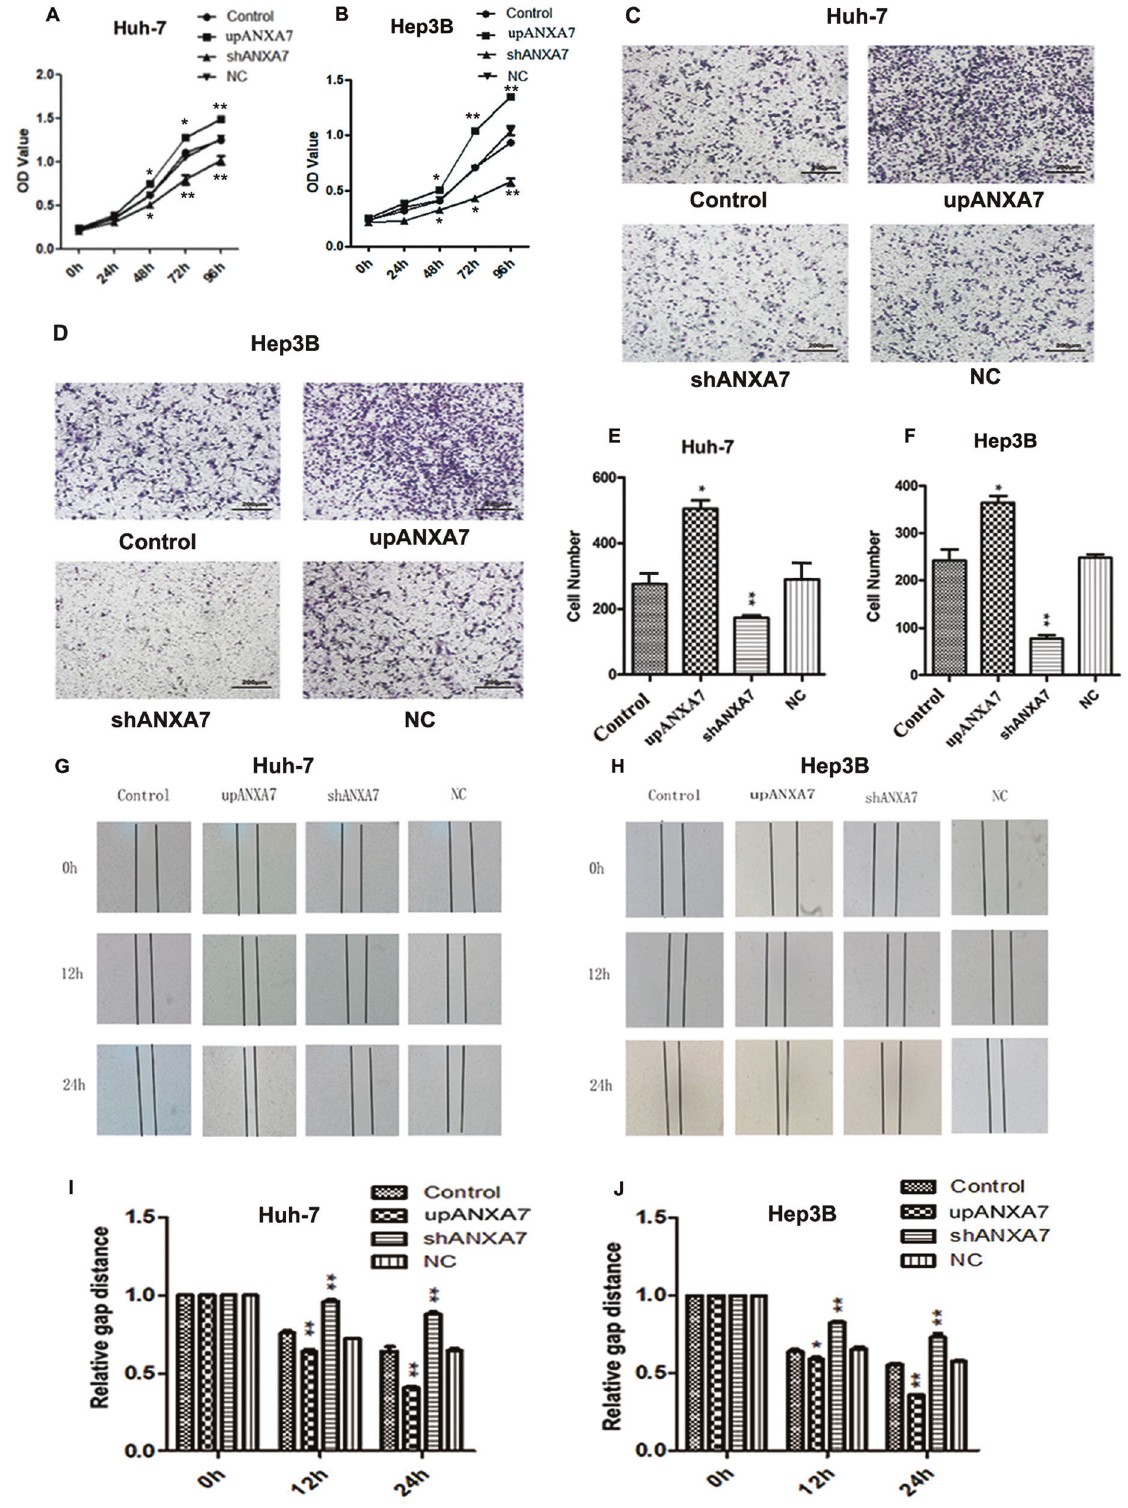
Fig. 4 The expression of ANXA7 affects the proliferation, invasion, and migration of HCC cells. A , B CCK8 assays showed that ANXA7 upregulation promoted the proliferation, whereas ANXA7 downregulation suppressed the proliferation of Huh-7/Hep3B cells (* p < 0.05). C – F Transwell invasion assays showed that ANXA7 upregulation promoted invasion, whereas ANXA7 downregulation inhibited invasion of Huh-7/ Hep3B cells (** p < 0.01, * p < 0.05). G – J Representative images of wound-healing assays showed ANXA7 upregulation promoted the migration of HCC cells, whereas ANXA7 downregulation inhibited its migration at 0 h,12 h, and 24 h (** p < 0.01, * p < 0.05).